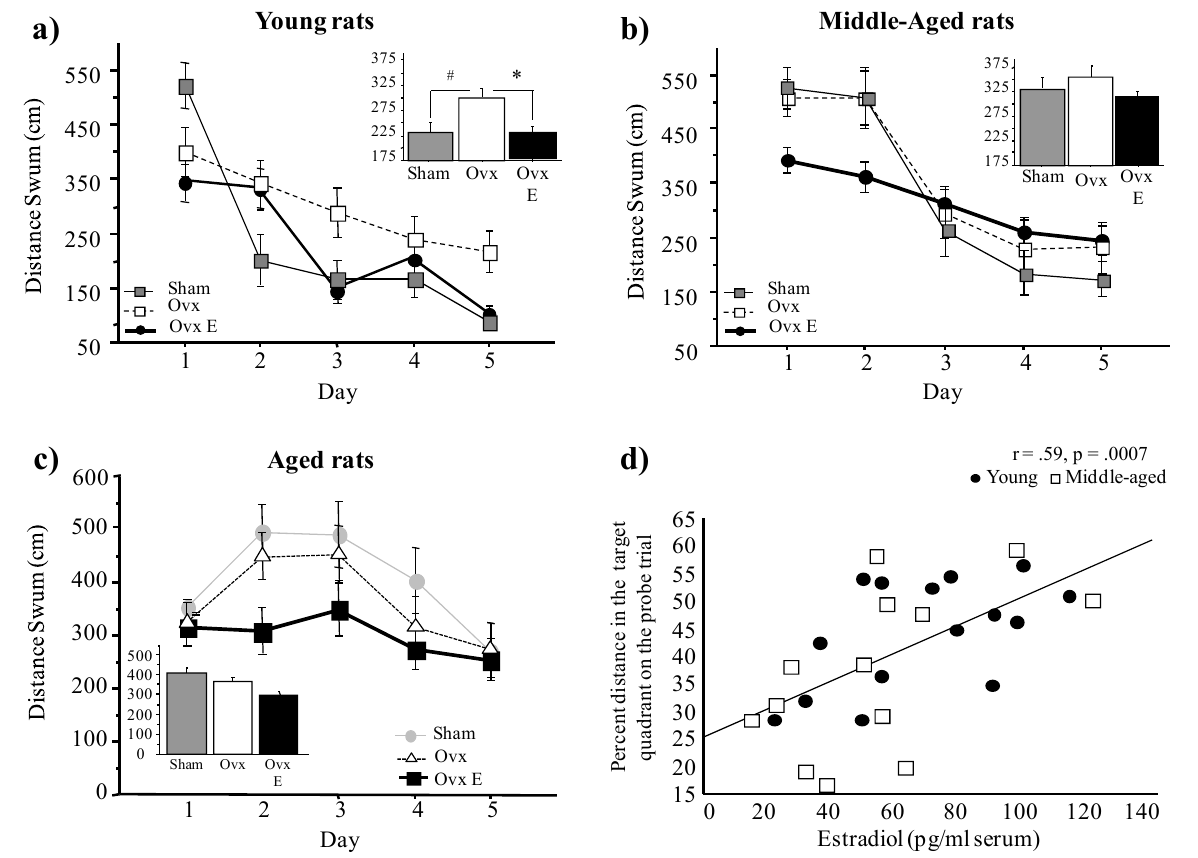
Figure 4. Age alters responsiveness to Ovx and 17 β -estradiol treatment, and serum levels of 17 β -estradiol correlate with memory scores in young and middle-aged rats [53]. Mean ± SE distance scores (cm) on the reference memory Morris maze for a) young Sham, Ovx and OvxE groups, b) middle-aged Sham, Ovx and OvxE groups, and c) aged Sham, Ovx, and OvxE groups; the inset graphs represent data collapsed across days. Ovx impaired performance on the latter portion of testing for young animals, while there was no effect of Ovx in middle-aged animals. 17 β -estradiol treatment enhanced performance in both young and middle-aged groups. For aged Sham, Ovx, and OvxE groups there were no significant main effects or interactions for distance scores due to Ovx or 17 β -estradiol replacement. Thus, there was a dissociation between sensitivity to Ovx and responsiveness to estrogen treatment. * p < 0.05, # p = 0.06, *** p < 0.0001. d) For the scatterplot, young animals are represented by filled circles, and middle-aged animals by unfilled squares. Higher circulating 17 β -estradiol levels were correlated with better spatial reference memory, as tested on the Morris